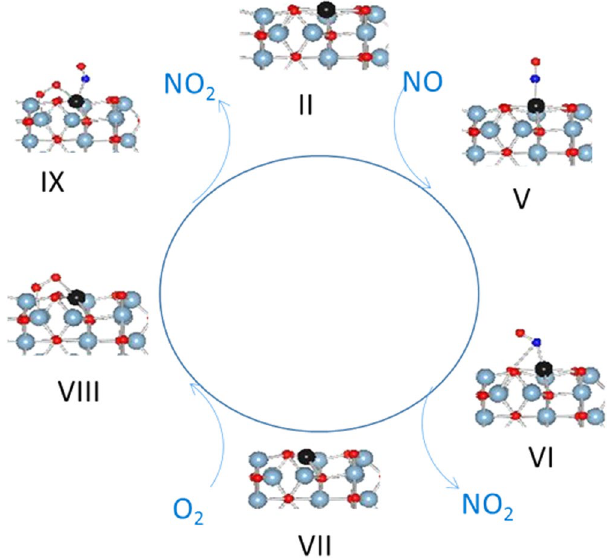
Figure 7. The NO oxidation cycle on a single supported Pd cation with alumina as the oxygen